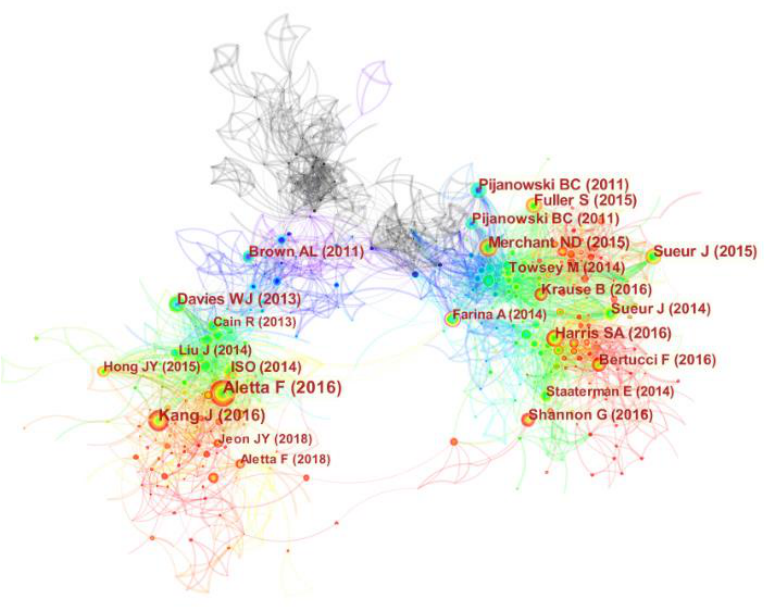
Figure 5. A network map showing literature co-citation in soundscape research [6,20–28]. Table 3 portrays the 10 most influential articles in the field of urban soundscape, sorted by the number of citations, and the table includes the first author’s name, citation frequency, publication year, and DOI. The literature by Francesco Aletta et al. (2016) was cited the most (119 times), followed by Kang Jian (105 times) and Bryan (76 times). Table 3. Top 10 most-cited literature studies in the field of soundscape.